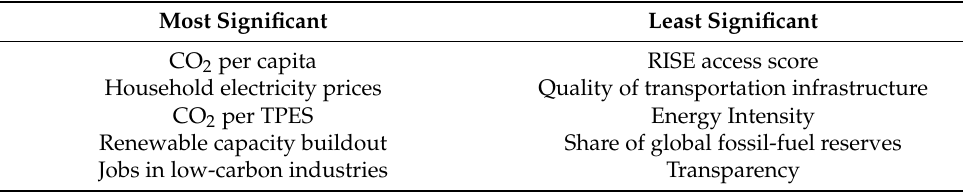
Table 4. The most and least significant variables of the Energy Transition Index.